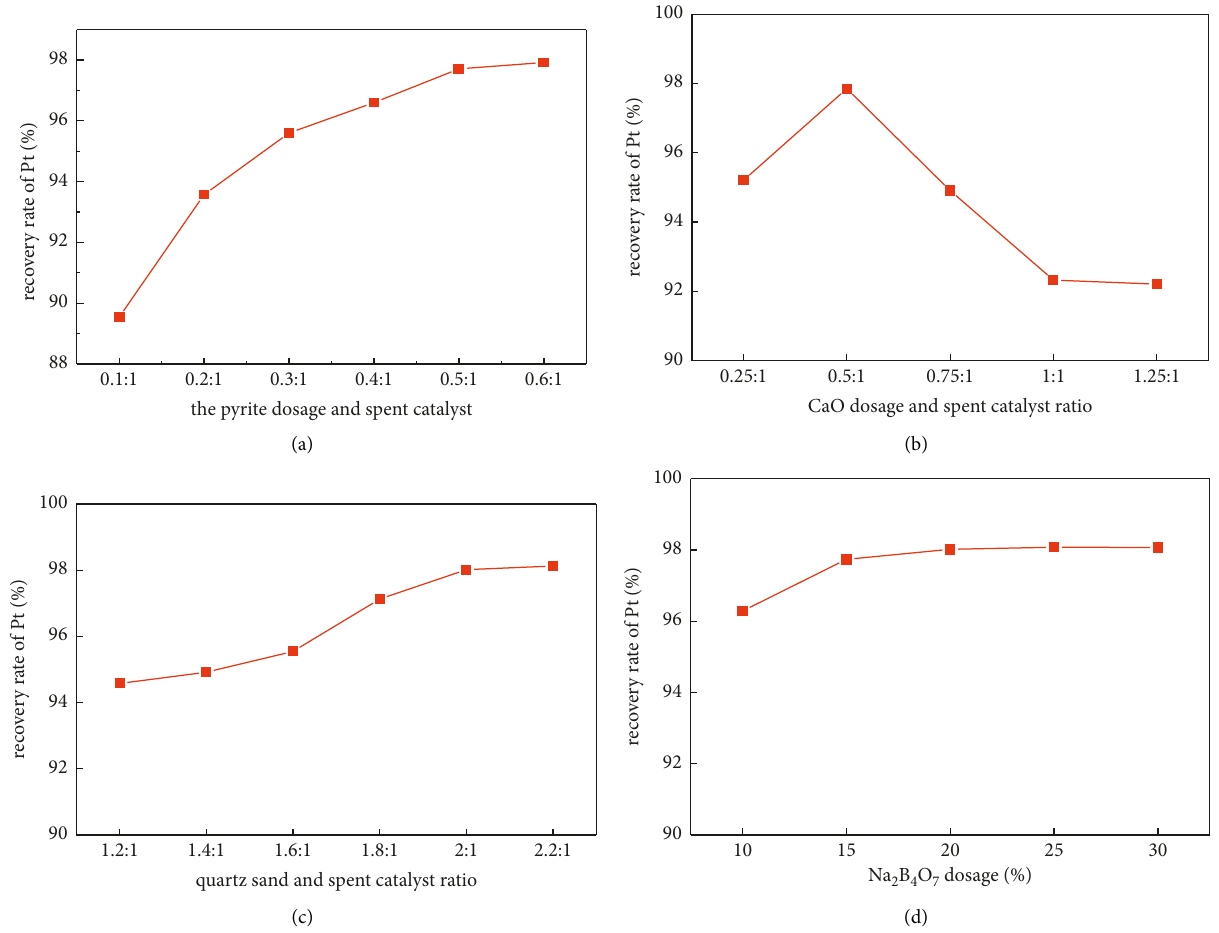
Figure 4: Pt recovery efficiency under different melting parameters. (a) Effect of trapping agent on recovery rates of Pt. (b) Effect of CaO dosage on recovery rates of Pt. (c) Effect of quartz sand on recovery rates of Pt. (d) Effect Na 2 B4O 7 dosage on recovery rates of Pt.